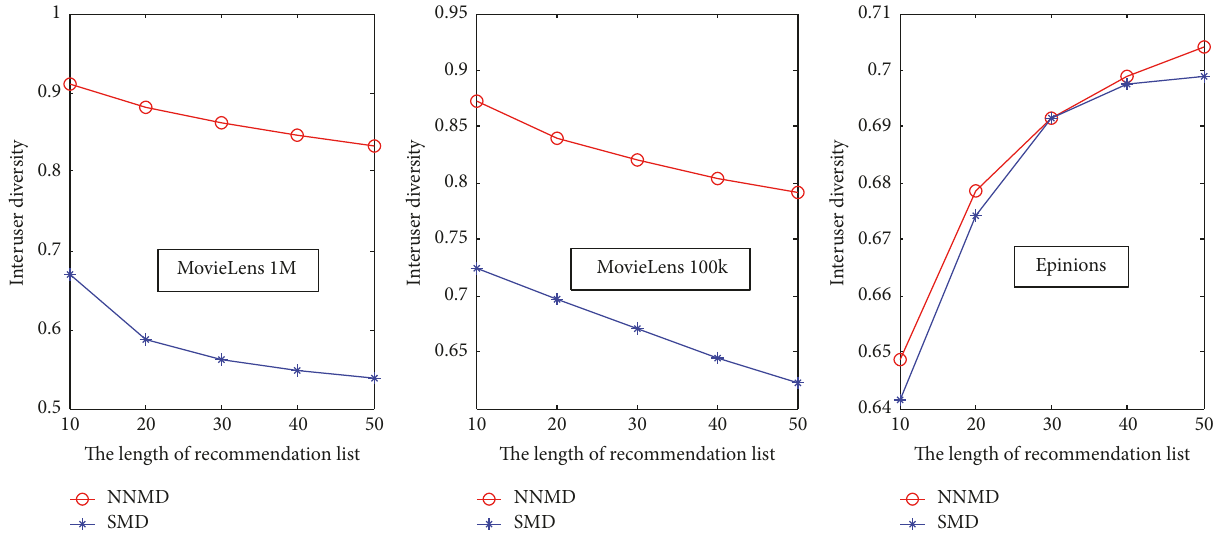
Figure 5: The interuser-diversity of the NNMD and SMD algorithm in MovieLens 100k, MovieLens 1M, and Epinions under different length of recommendation list. The parameters for the NNMD algorithm are 𝑁 = 50 and 𝛼 = 0.9 in MovieLens 100k and MovieLens 1M while they are 𝑁 = 10 and 𝛼 = 0 in